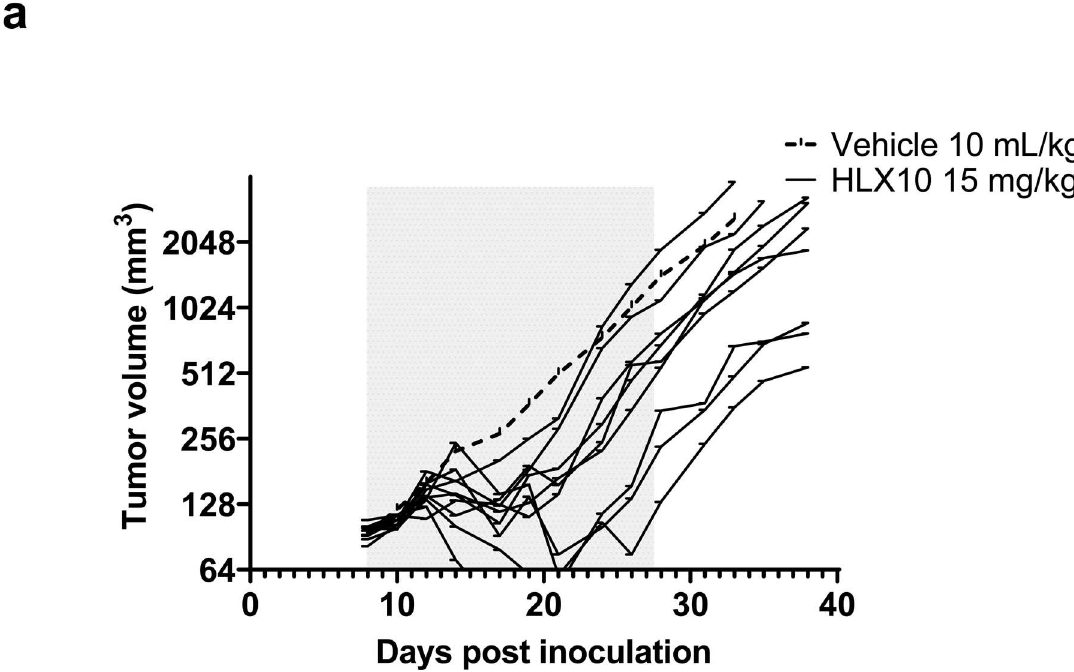
Fig 6. Growth of EMT breast cancer syngeneic tumors was measured in PD-1 knock-in mice following 6 injections (gray area) of either vehicle buffer (10 mL/Kg),or HLX10 (15 mg/kg), and 2 weeks after the last dose (day 25); n = 10 mice/group. Average tumor size of vehicle control (plotted as dashed line) and individual growth curves (solid lines) of HLX10 are shown.